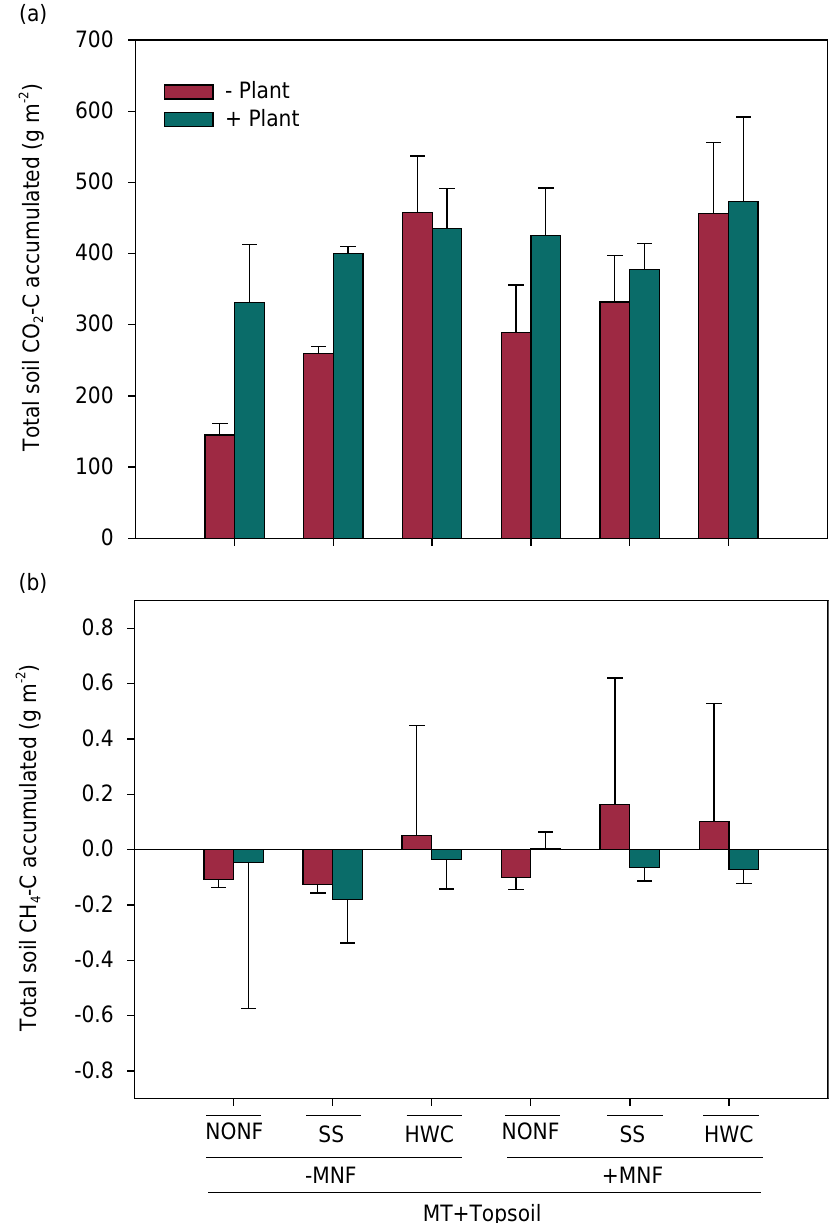
Figure 3. Total soil CO 2 -C accumulated (g m -2 ; a) and total soil CH 4 -C accumulated (g m -2 ; b) 78 days after the planting in iron mining tailing + Topsoil (MT + Topsoil), without (-Plant) and with plant (+Plant), without (-MNF) and with mineral-N fertilization (+MNF), and different organic-N fertilization (non-organic-N fertilization, sewage sludge - SS, and household waste composting - HWC). No significant differences were verified to total soil CH 4 -C accumulated according to the Kruskal-Wallis multiple-comparison Z-value test. Vertical bars represent the means ± 90 % confidence interval (n =